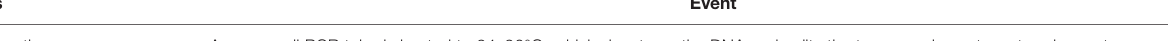
Template DNA Double-stranded DNA segment to be copied dNTPs